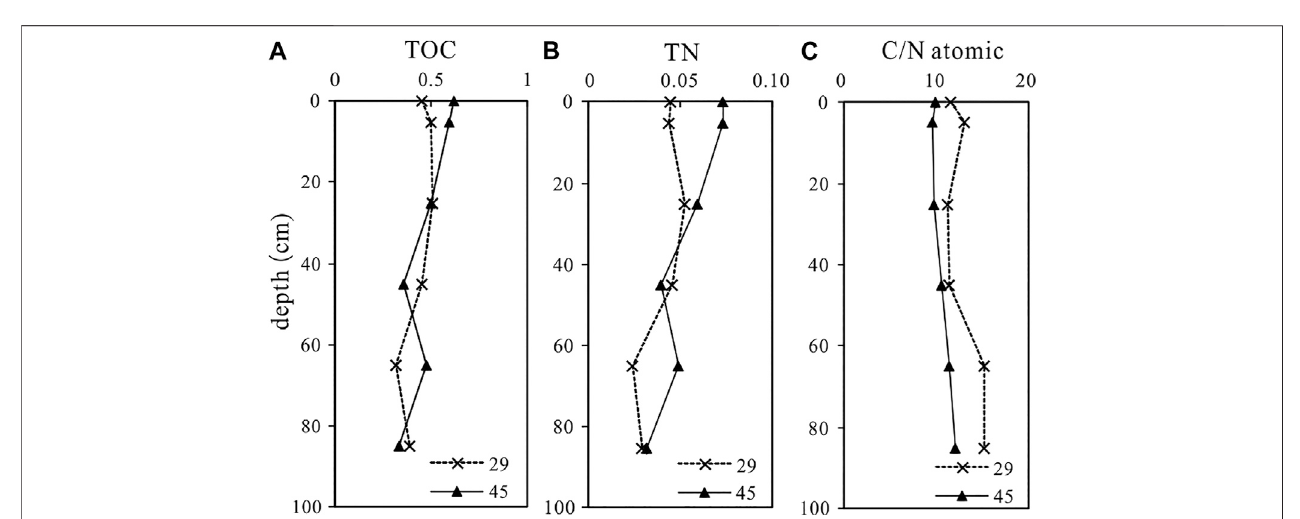
FIGURE 2 | Depth pro fi le of TOC, TN and atomic C/N ratio for core 29 and core 45.